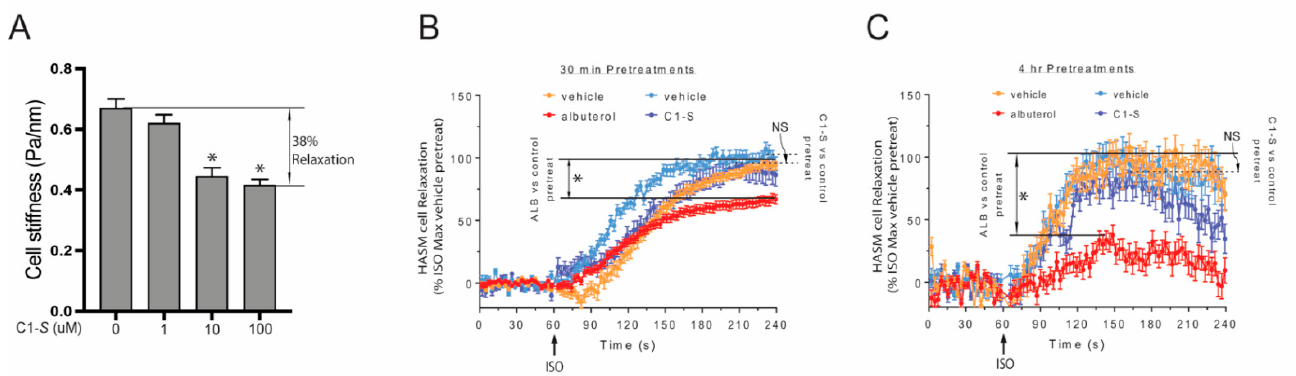
Figure 5. Physiologic confirmation of C1-S biasing away from β -arrestin and desensitization. ( A ) C1-S relaxes human ASM cells. Cell stiffness was measured my magnetic twisting cytometry, where a decrease in stiffness equates with relaxation. A ~38% relaxation response was observed with C1-S. *, p < 0.01. ( B , C ) C1-S, but not albuterol, fails to promote desensitization of the relaxation response to the full agonist isoproterenol (ISO). Human ASM cells were pretreated for 30 min or 4 h with vehicle (control), C1-S (100 μ M), or albuterol (1.0 μ M), washed, and then the relaxation response to isoproterenol (10 μ M) was measured in real time. Albuterol pretreatment resulted in a ~35% ( B ) and ~70% ( C ) loss of ISO-evoked relaxation with the two pretreatment time points, respectively (*, p < 0.01). In contrast, C1-S incubation for either duration resulted in no statistically significant loss of β 2 AR function as assessed by ISO-evoked relaxation. NS = not significant.